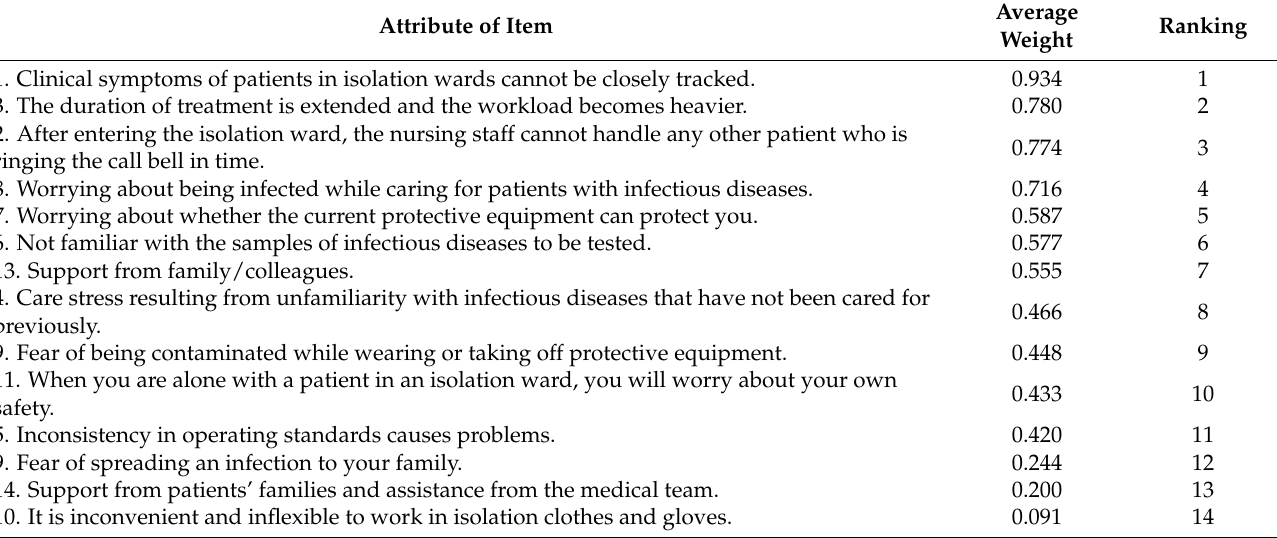
Table 6. Ranking of the weights of stress